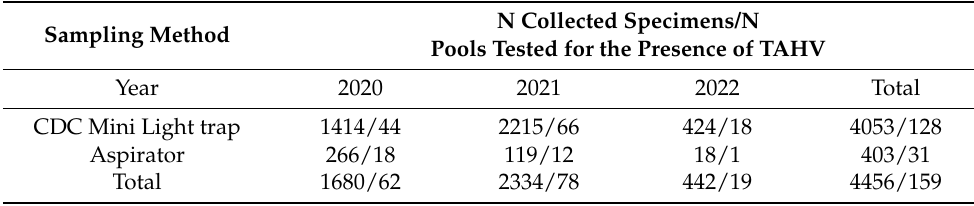
Figure 4. Tahyna virus-neutralizing antibody titers in humans and animals. A total of 4456 Ae. vexans mosquitoes were collected and identified in the Zagreb area, of which 4053/90.9% mosquitoes were sampled by traps with CO 2 , while 403/9.1% were sampled by the aspirator. Mosquito specimens were sorted in 159 pools and tested for the presence of TAHV (Table 5). All tested pools were negative for TAHV. Table 5. Number of collected Aedes vexans mosquitoes/pools tested for Tahyna virus. N Collected Specimens/N Sampling Method Pools Tested for the Presence of